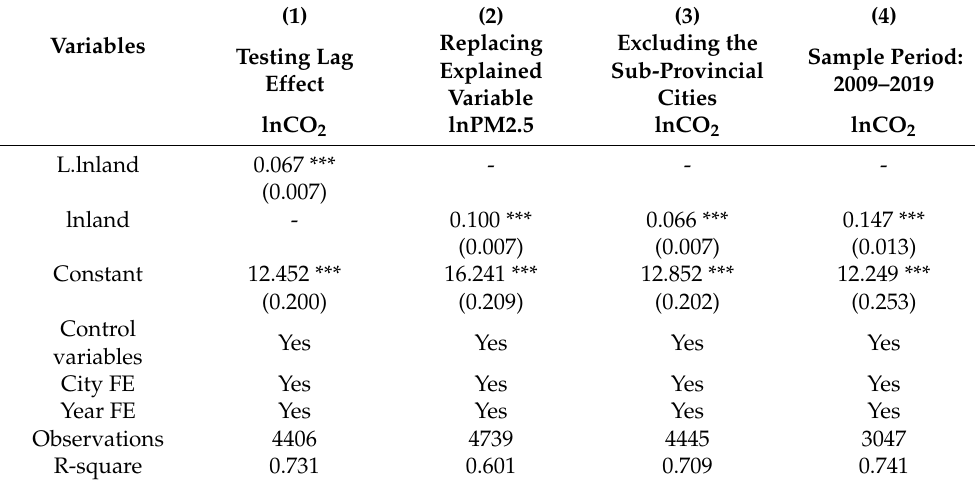
Table 4. The results of robustness tests